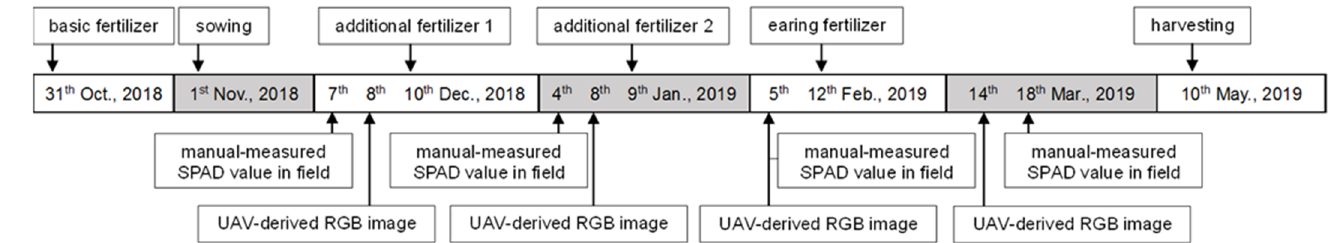
Figure 2. Timetable of the experiment.